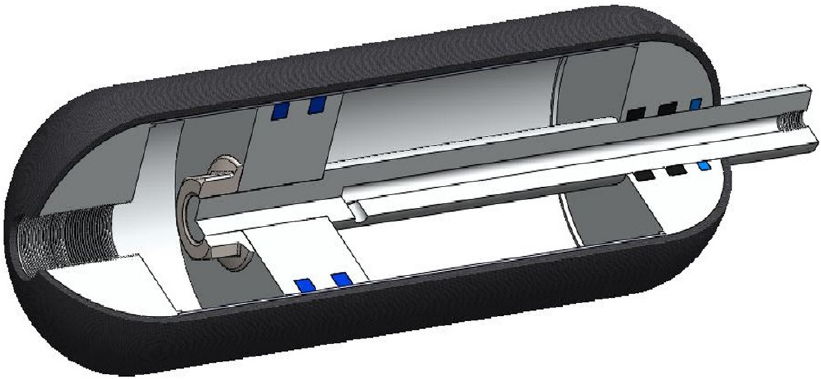
Figure 8. Schematic visualization of the composite hydraulic cylinder design by Coskun and Sahin [42].